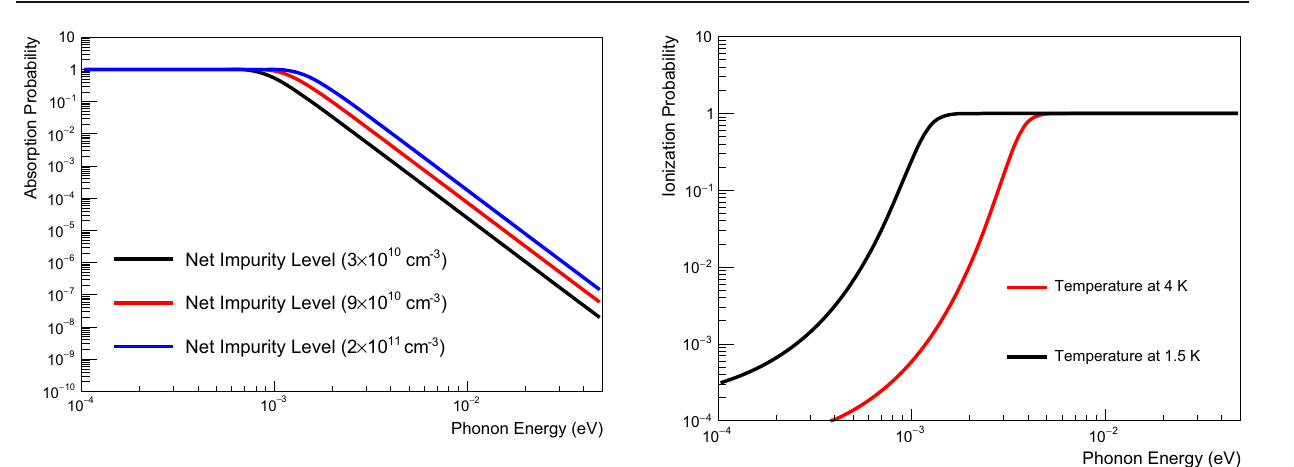
Fig. 9 Shown is the ionization or excitation probability as a function of phonon energy in a given Ge